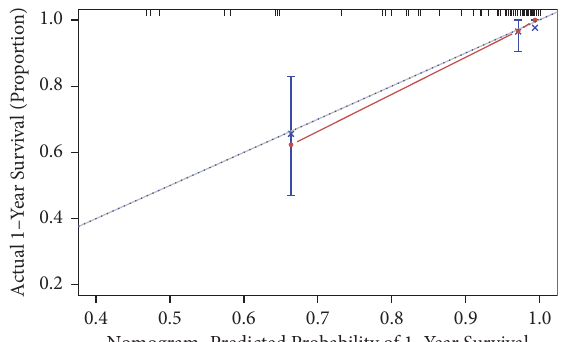
Figure 7: Calibration curve for one-year survival